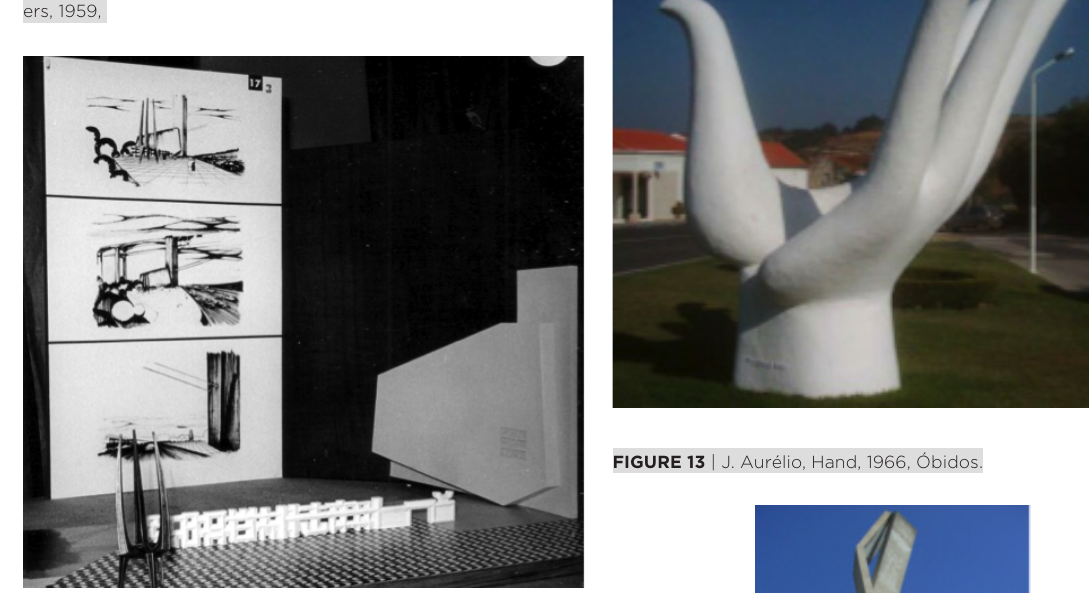
FIGURE 10 | A Siza, L. Henriques, L Cunha, Monument to Caulk-